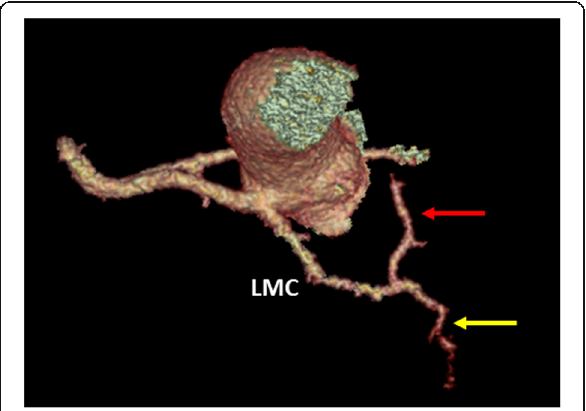
Fig. 3 CCT VR reconstruction showing the left anterior descending artery (red arrow) and left circumflex artery (yellow arrow) originating from the left main coronary artery (LMC) after the intraseptal